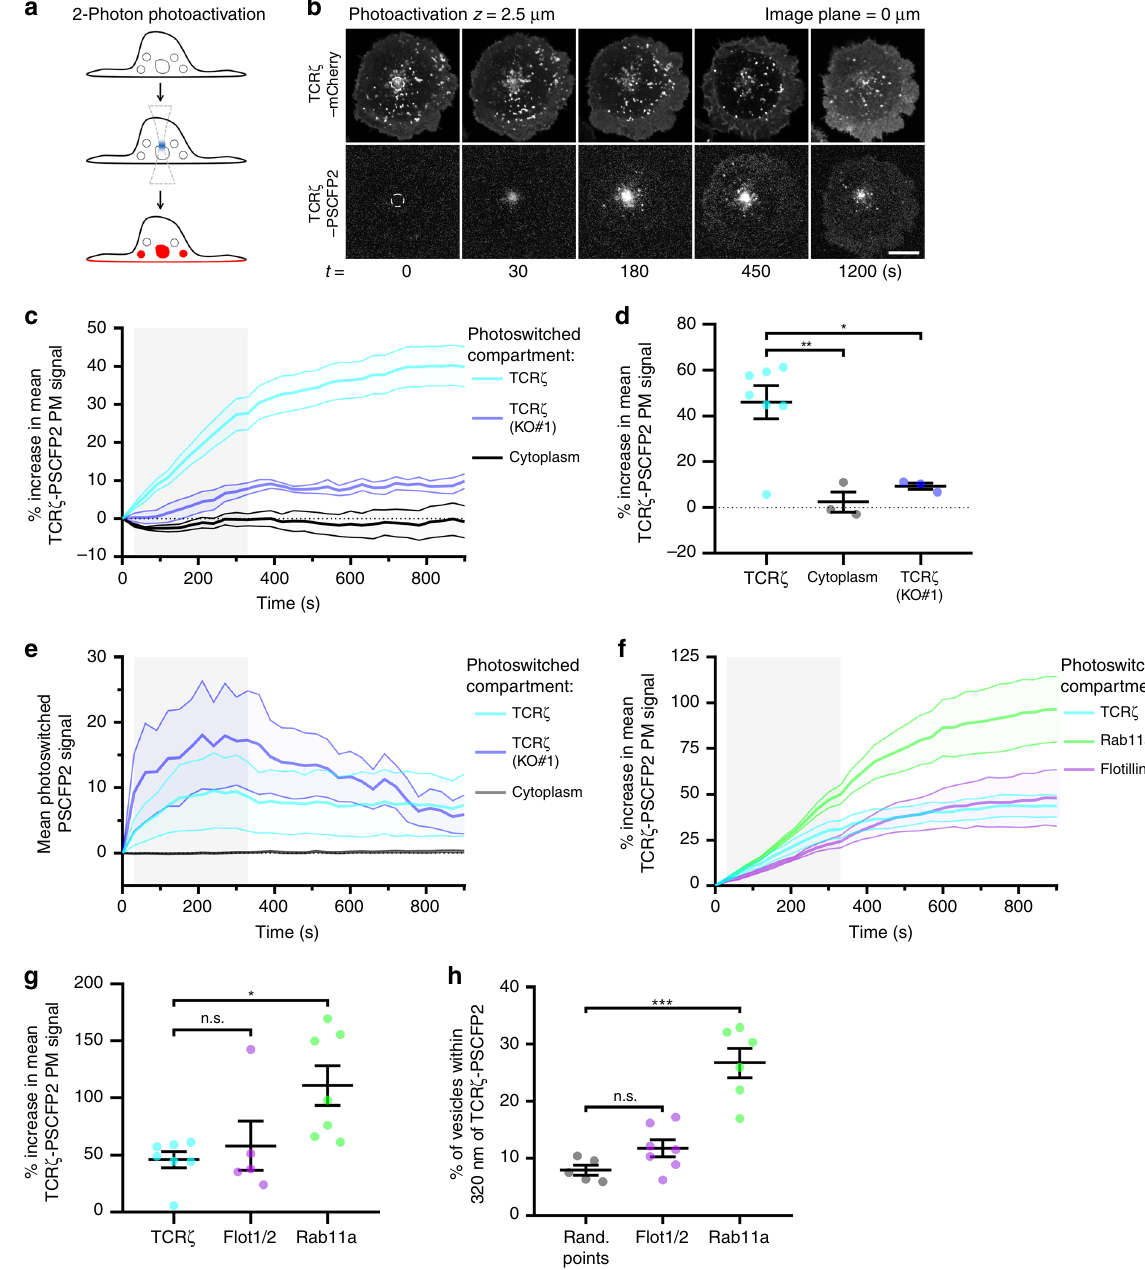
Fig. 2 TCR ζ recycles from an intracellular compartment labelled by fl otillins and Rab11a. a Schematic depicting two-photon photoactivation to measure recycling from intracellular compartments. b Representative confocal images of TCR ζ -PSCFP2 photoactivated with 800 nm light from a two-photon laser, 2.5 µ m within the cell at the cell centre-localised TCR ζ -mCherry compartment displaying recycling to the plasma membrane over time. Dashed circle = photoactivation region. c % increase in photoactivated TCR ζ -PSCFP2 signal over time at the plasma membrane when activated from cell centre compartments labelled by TCR ζ -mCherry in WT or FlotKO Jurkat T cells or cytoplasmic photoactivation. Greyed region = time of photoactivation. d Mean TCR ζ -PSCFP2 signal from 900 to 1200 s timepoints when photoactivated from the indicated compartments. e Mean intenisty of photoactivated TCR ζ - PSCFP2 2 µ m within the cell from TCR ζ -mCherry in WT or FlotKO cells. Greyed region = time of photoactivation. f % increase in photoactivated TCR ζ - PSCFP2 signal over time at the plasma membrane when activated from cell centre compartments labelled by mCherry-Rab11a, fl otillin1/2-mCherry or TCR ζ -mCherry in WT Jurkat T cells. Grey box = time of photoactivation. Greyed region = time of photoactivation. g Mean TCR ζ -PSCFP2 signal from 900 to 1200 s timepoints when photoactivated from the indicated intracellular compartments. h Percentage of photoactivated TCR ζ -PSCFP2 vesicles within 320 nm of vesicles of the indicated marker outside of the initial photoactivation region. Data points = means of independent experiments, error bars = mean ± SEM. n.s. = not signi fi cant, * p < 0.05, ** p < 0.01, *** p < 0.001 from a two-tailed unpaired Student ’ s T -test of means of n = 7 (TCR ζ : 3; 3; 1; 1; 1; 1; 1 cells per experiment), 5 ( fl otillin1/2: 2; 1; 1; 1; 1 cells per experiment), 7 (Rab11a: 1; 1; 2; 1; 1; 1; 1 cells per experiment), 3 (cytoplasm: 3; 1; 2 cells per experiment), and 3 (TCR ζ in FlotKO: 1; 1; 2 cells per experiment) biologically independent experiments. Scale bar = 5 µ